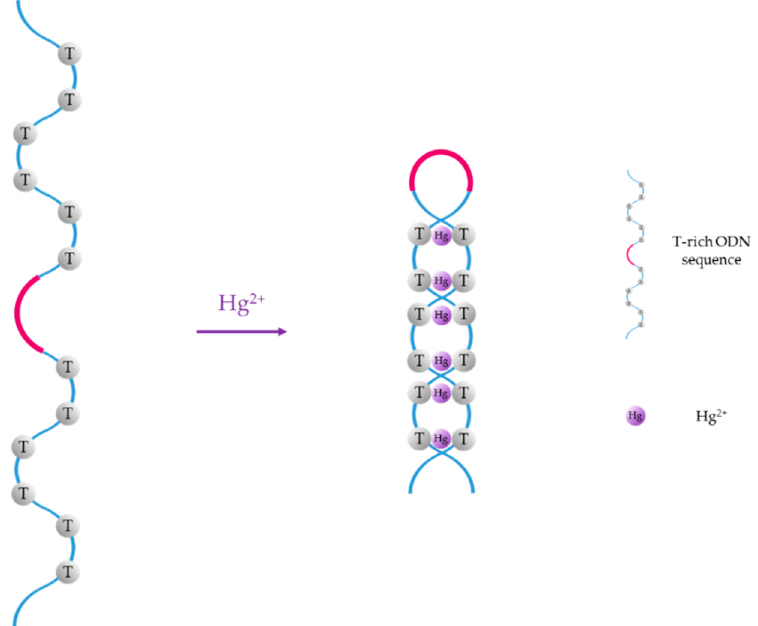
Figure 1. Hg 2+ -induced formation of T-Hg 2+ -T mismatches.